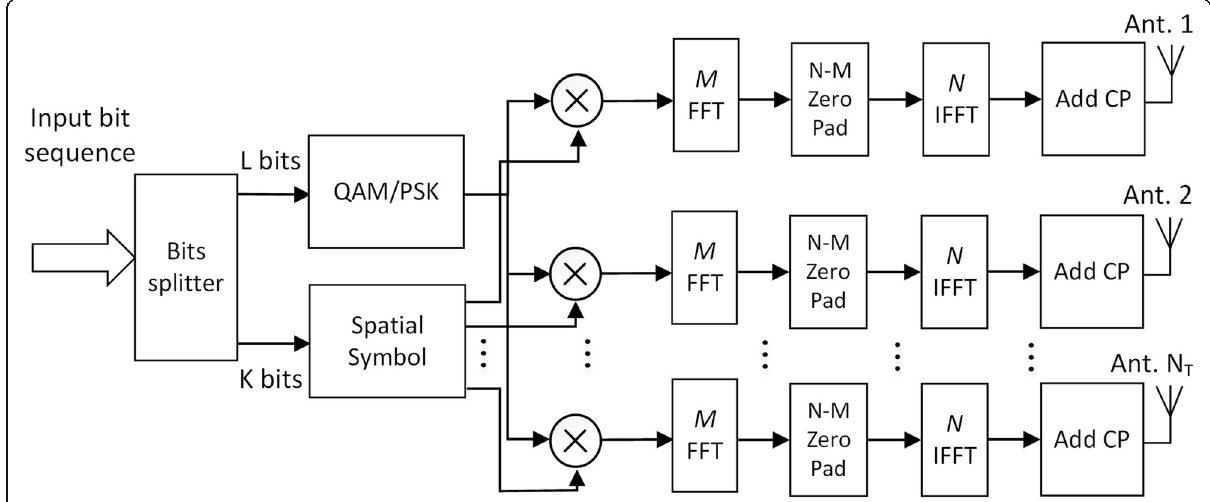
Fig. 1 The block scheme of the proposed SC-FDMA SS-GLPSM transmitter with N T antennas. The input bit sequence is divided into two subsequences. The first is used for QAM/PSK mapping and the second for the selection of the spatial symbol. For each transmit antenna, the QAM/PSK symbol is multiplied with the corresponding GLPSM coding coefficient. After that, independent SC-FDMA modulations are performed for each transmit